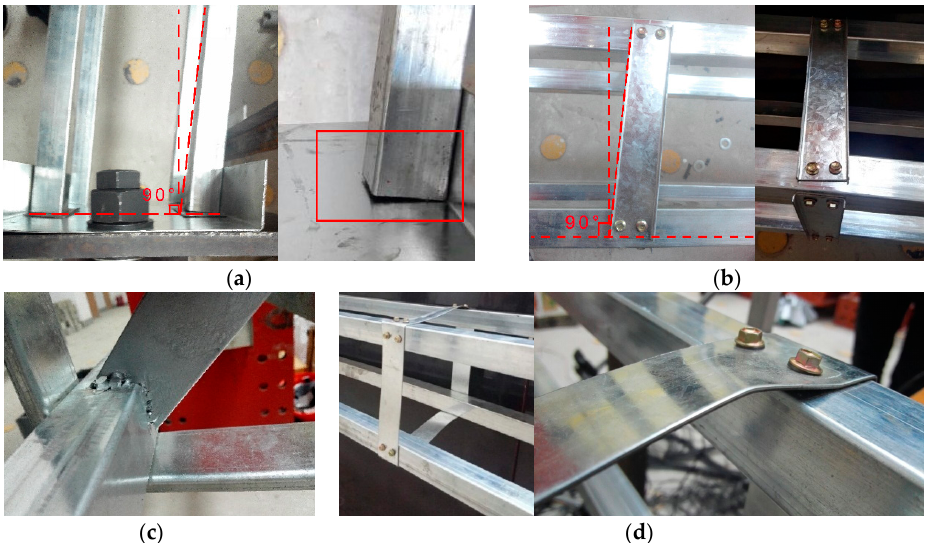
Figure 5. Deformed shapes at failure : ( a ) S1; ( b ) S2; ( c ) S3; ( d ) S4.